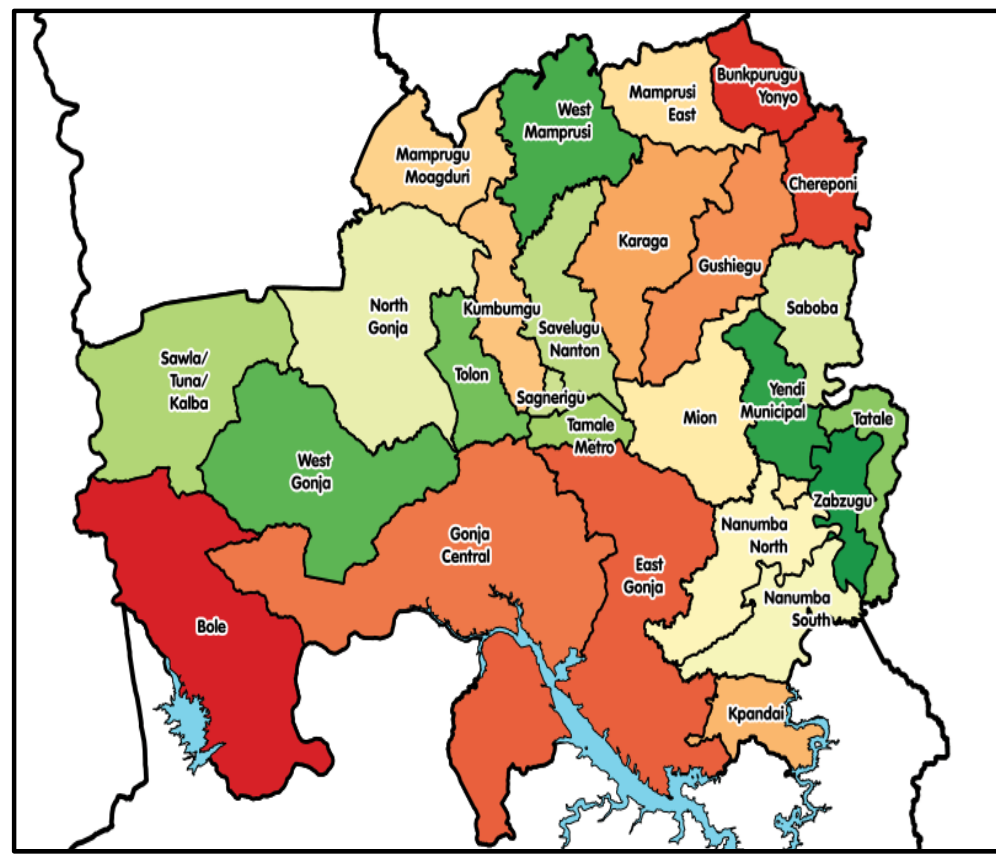
Figure 1: Map of Northern